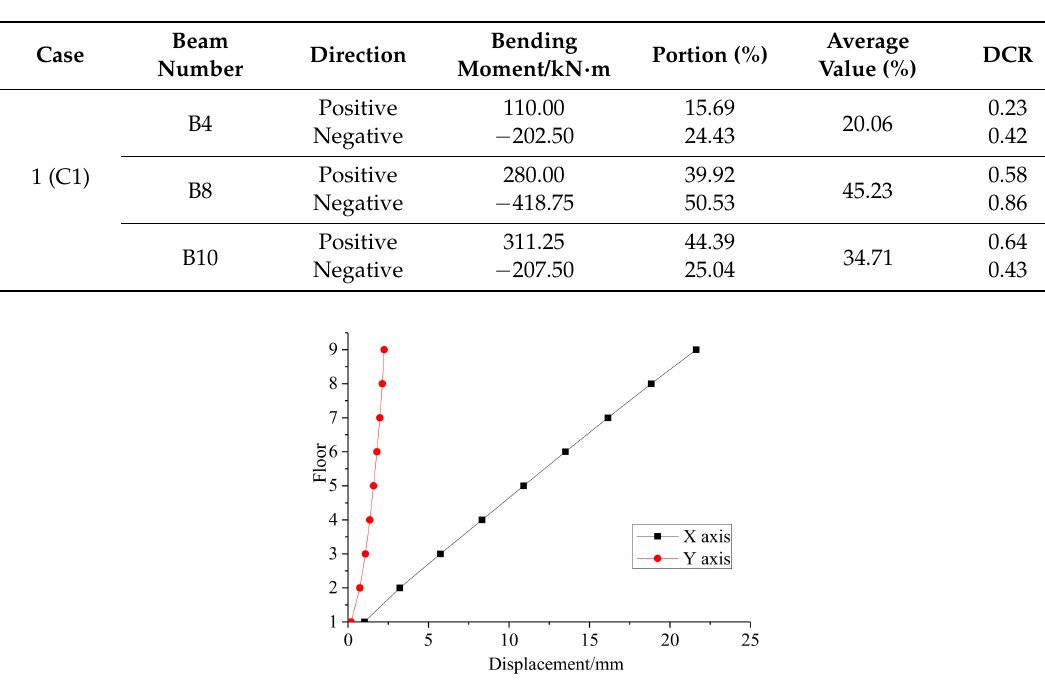
Figure 15. Displacement of structure in case 1.